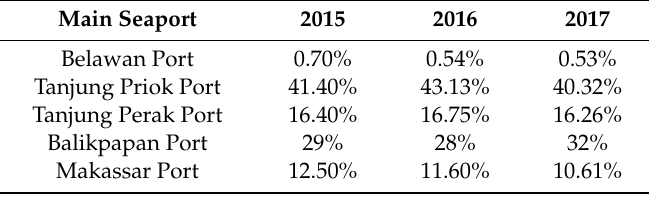
Table 1. Percentage of total domestic commodity loads in Indonesia’s 5 main ports 2015–2017.